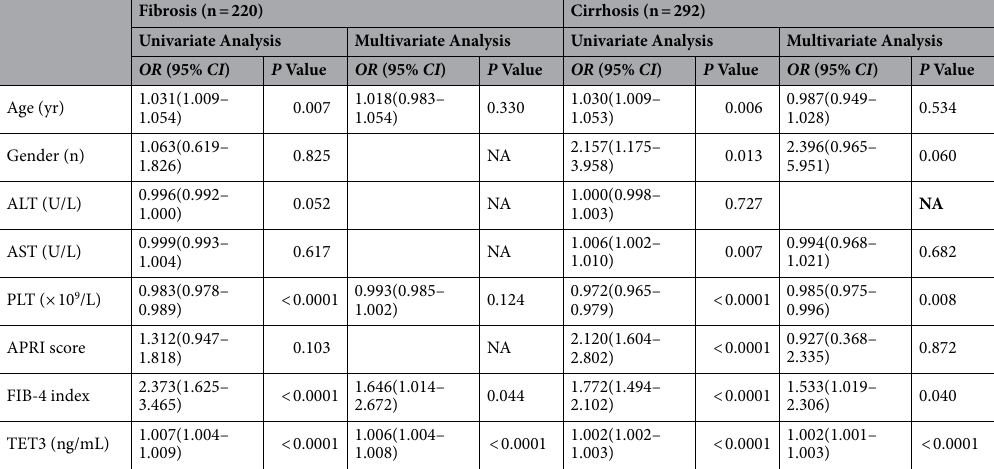
Table 3. Univariate and multivariable analyses for liver fibrosis and cirrhosis. NA: not adopted.